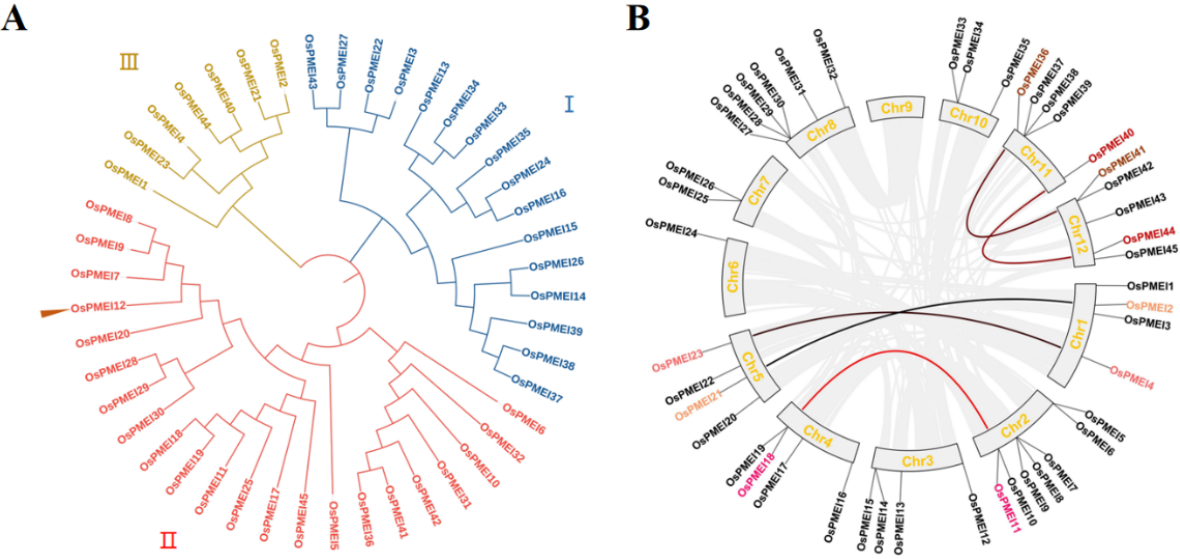
Figure 1. Phylogenetic relationship ( A ), and chromosomal distribution and duplication events ( B ) of the OsPMEI family in rice.